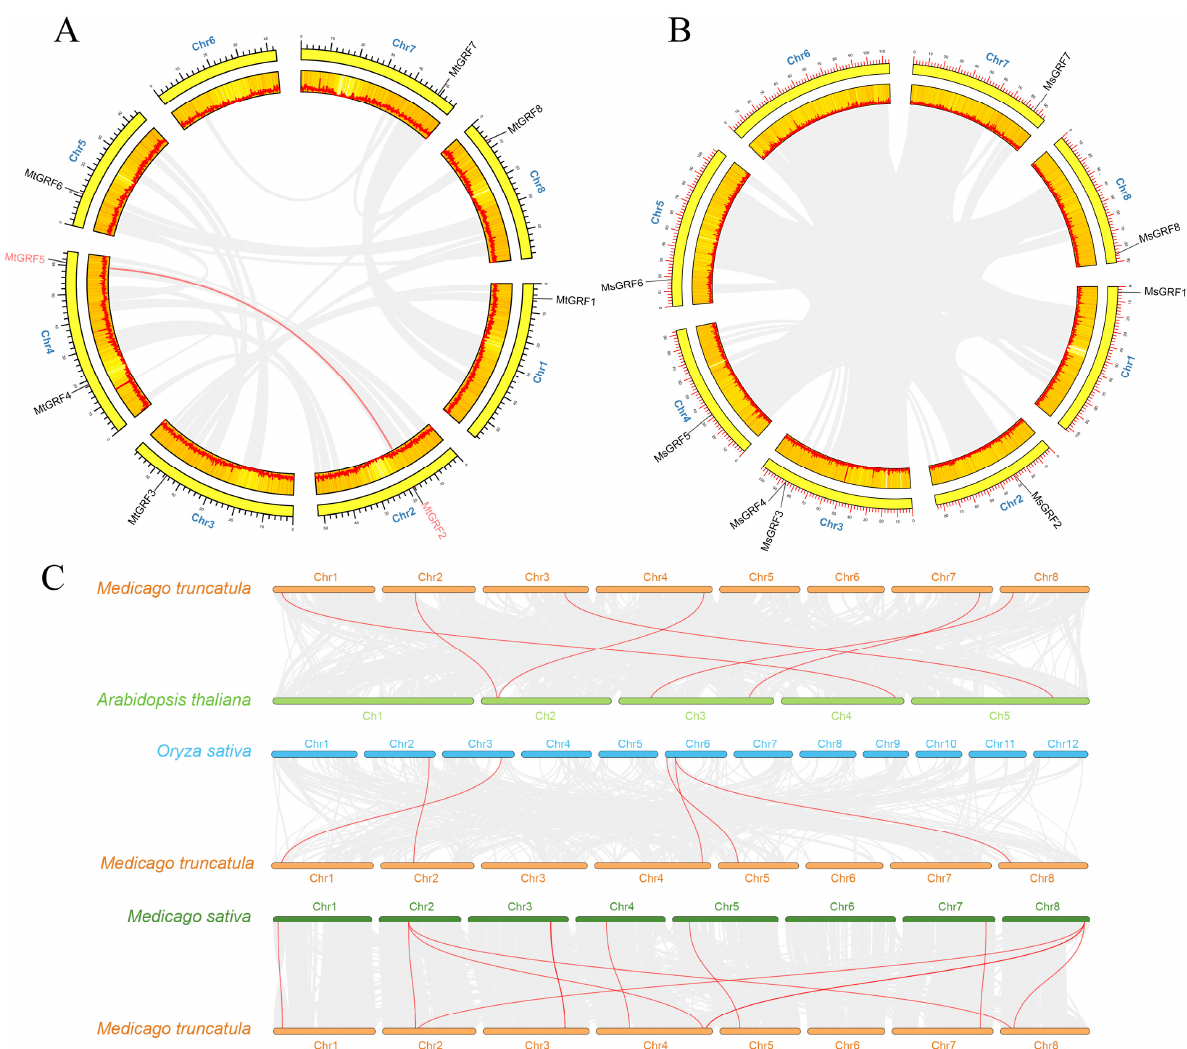
Figure 4. Chromosome distributions of GRFs in M. truncatula and M. sativa . The chromosomal location and interchromosomal relationship of M. truncatula ( A ) and M. sativa ( B ). The segmentally duplicated genes are connected by red curves. ( C ) Synteny analysis of GRF genes between A. thaliana and M. truncatula , O. sativa and M. truncatula , M. sativa and M. truncatula . Gray lines in the background indicate the collinear blocks between M. truncatula , and A. thaliana / O. sativa / M. sativa , and the red lines highlight the syntenic GRF gene